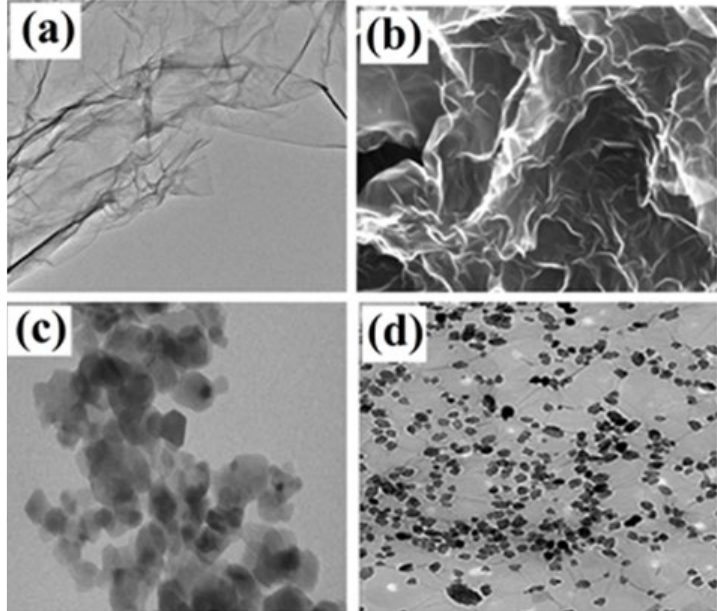
Fig. 6: TEM micrographs of (a) GO, (b) NG, (c) CoFe Fig. 6 TEM micrographs of (a) GO, (b) NG, (c) CoFe 2 O 4 and (d) NG@CoFe 2 O 4